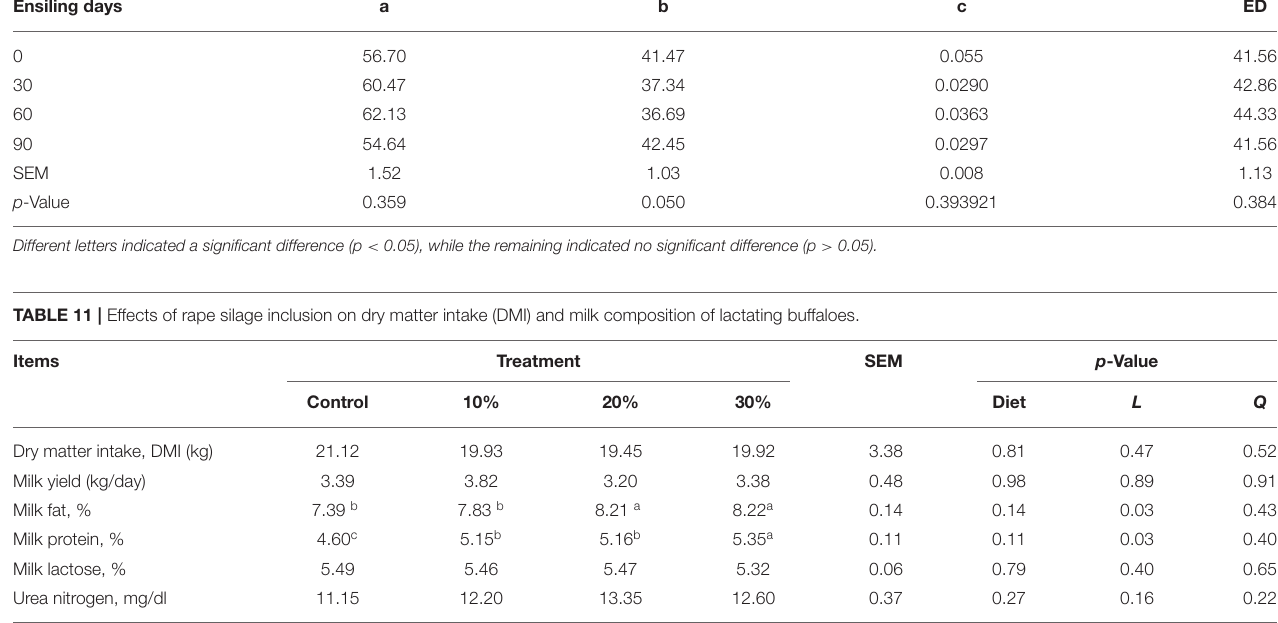
The different letters means significant difference (P <